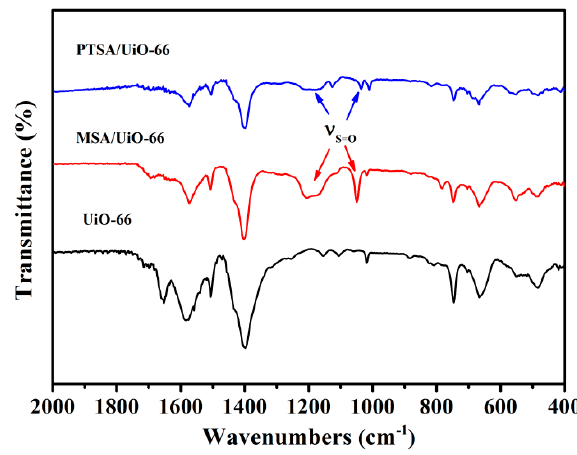
Figure 2. Fourier transform infrared spectroscopy (FT-IR) spectra of prepared UiO-66 and UiO-66- supported acids.